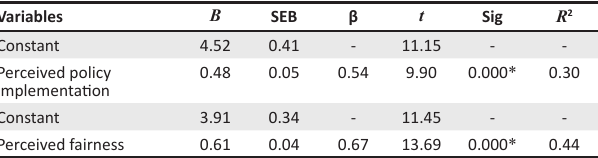
TABLE 5: Regression analysis.